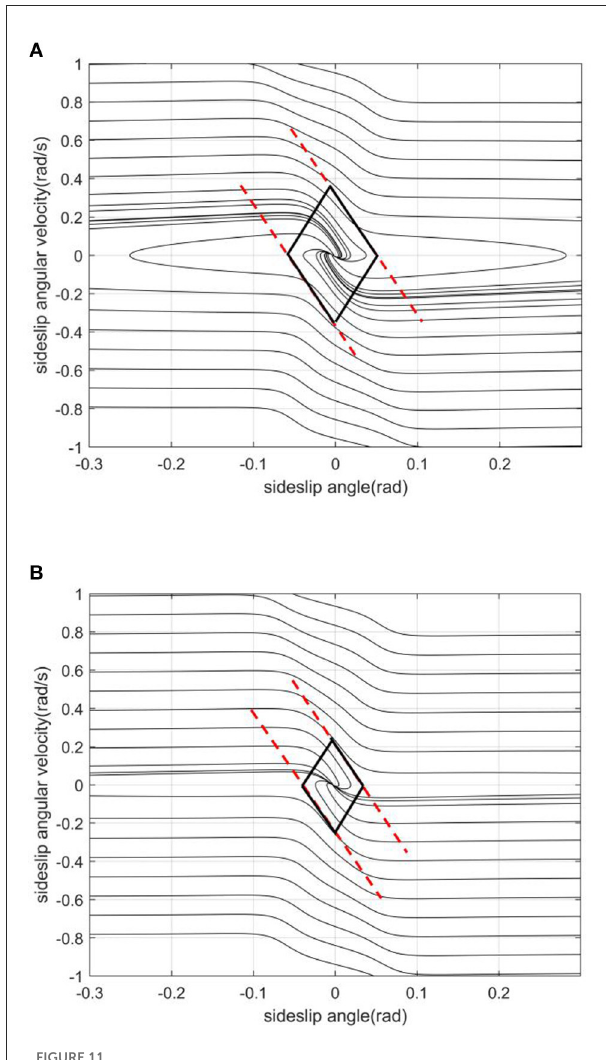
FIGURE11 [ µ , v , δ ] = [0.2, 20, 0]. (A) a / L = 0.4. (B) a / L =